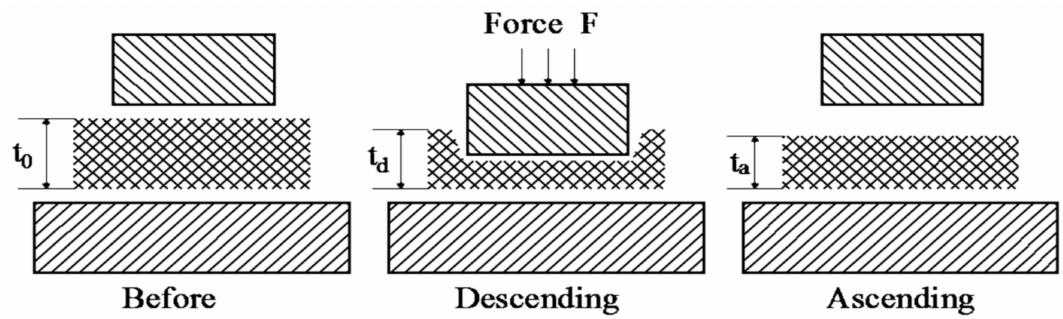
Figure 3. Measurement of compression